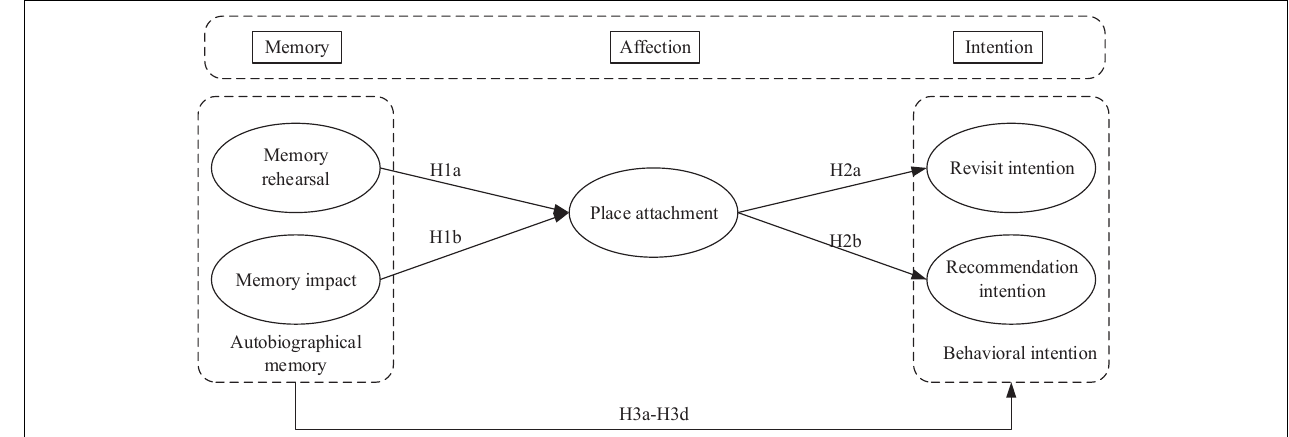
FIGURE 1 | Conceptual